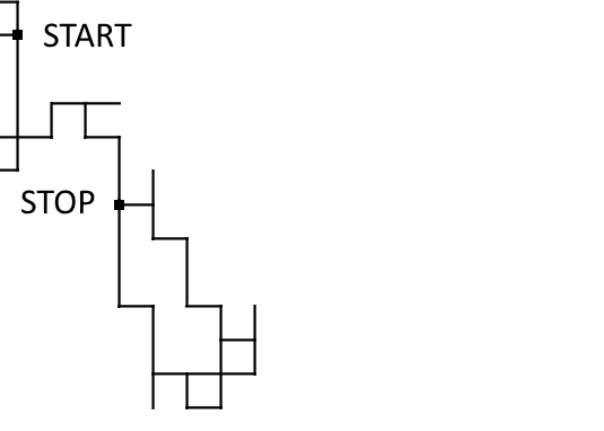
Figure 1. Fifty-four step random walk from a central point on a complex plane. Based on DNA sequence from Example